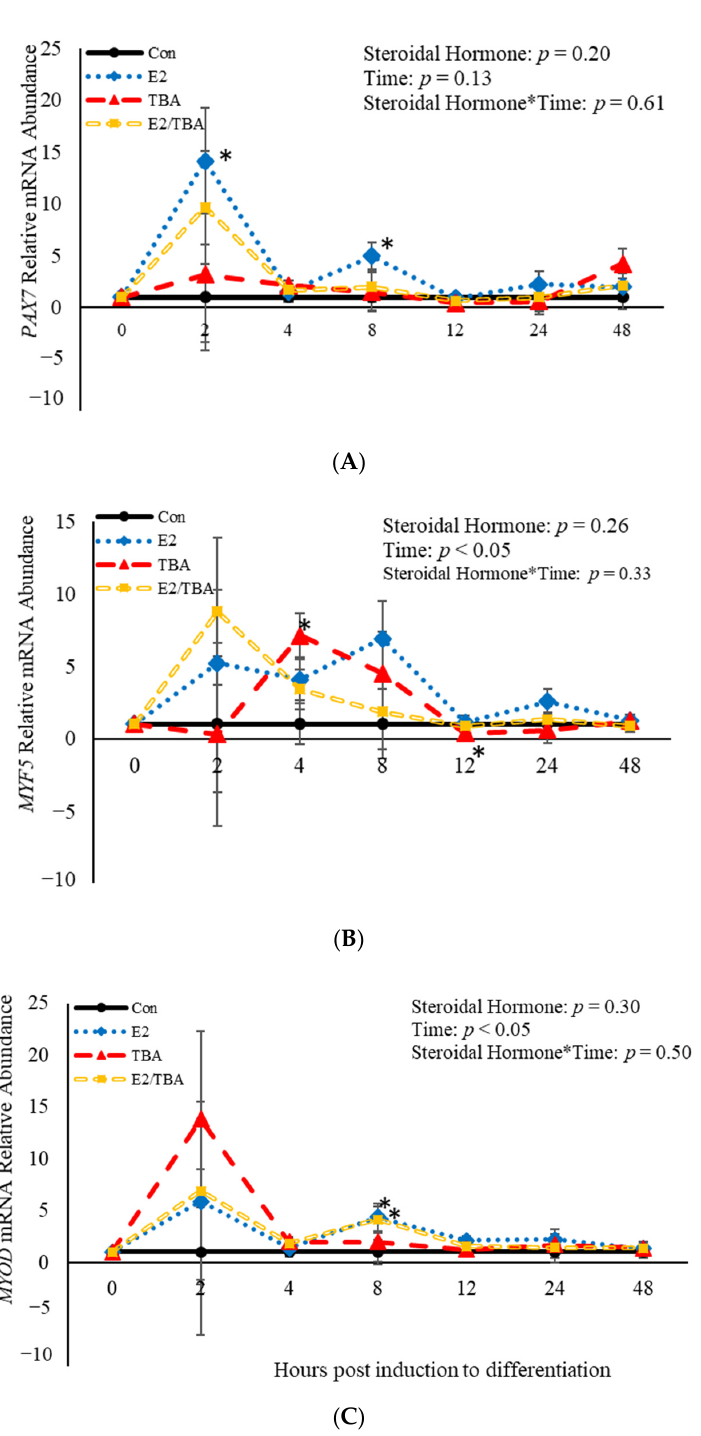
Figure 2. Relative mRNA abundance of paired box transcription factor 7 ( PAX7 ; ( A ) , myogenic factor 5 (MYF5; ( B ), and myogenic differentiation factor 1 (MYOD ; ( C ) from primary bovine satellite cells cul- tures following treatment with 10 nM trenbolone acetate (TBA), 10 nM estradiol (E2), or 10 nM E2 and 10 nM TBA (E2/TBA). Cultures were grown to 80% confluency and treated with DMEM/3% horse se- rum and 10 nM TBA, 10 nM E2, or 10 nM E2/TBA. Abundance was measured 0, 2, 4, 8, 12, 24 and 48 h